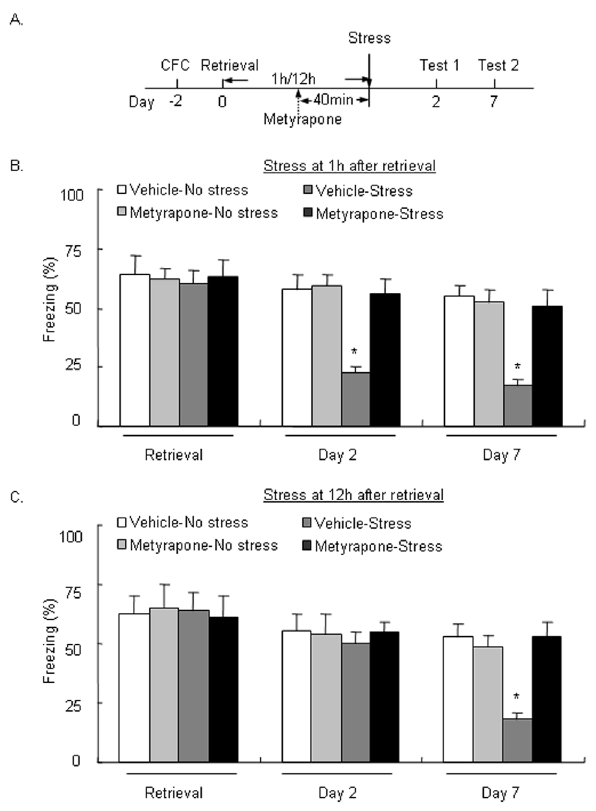
Figure 4. Metyrapone blocked the impairment of long-term memory formation and persistence induced by stress after fear memory retrieval. (A) Rats were pretreated with the corticosterone synthesis inhibitor metyrapone 40 min before exposure to cold water stress 1 or 12 h after retrieval of the memory of strong contextual fear conditioning (CFC) and then tested for long-term memory (LTM) on day 2 and day 7. (B) Metyrapone blocked the effects of stress 12 h after CFC retrieval on LTM formation on day 2 and decreased the persistence of LTM tested on day 7. (C) Metyrapone blocked the effects of stress 12 h after CFC retrieval on the persistence of LTM tested on day 7 but did not affect LTM formation tested on day 2. The data are expressed as mean 6 SEM ( n =6 per group). * p , 0.05, compared with Vehicle-No stress group.